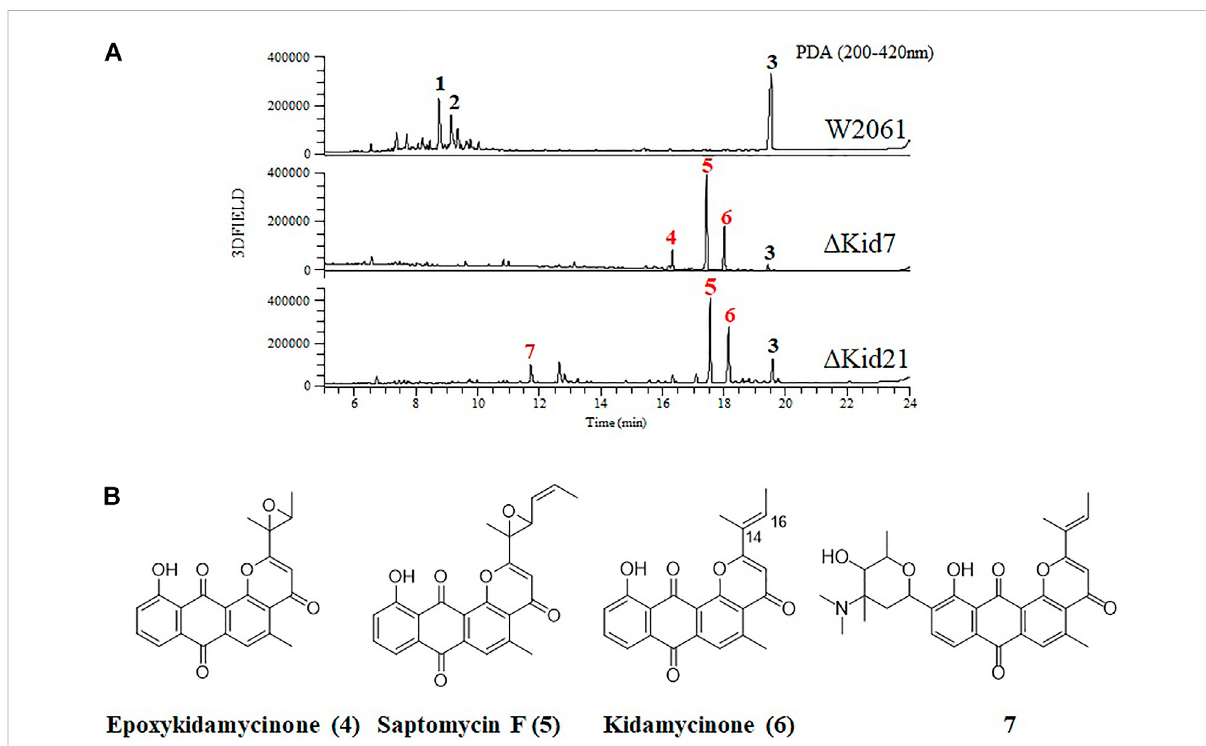
FIGURE 5 Disruption of kid7 and kid 21 gene loci. (A) HPLC analysis of the products of Streptomyces sp. W2061 (upper), Δ Kid7 (middle), and Δ Kid21 (bottom). (B) Structure of compounds epoxykidamycinone ( 4 ), saptomycin F ( 5 ), kidamycinone ( 6 ), and 7 isolated from the